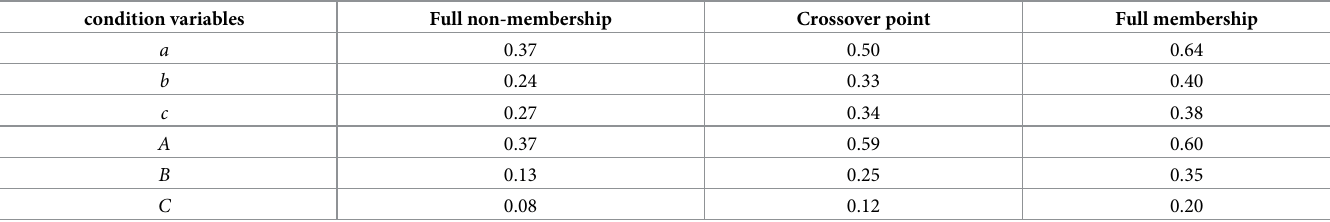
Table 3. Calibration criteria/thresholds of condition variables. condition